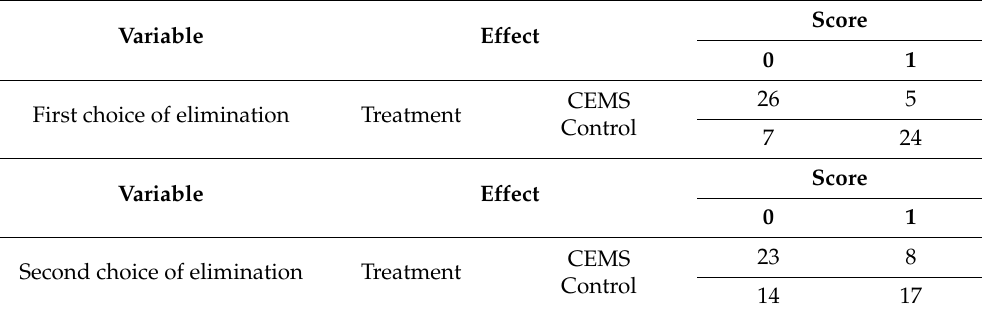
Table 4. Scores of first litter tray chosen to eliminate and on the second litter tray chosen to eliminate.